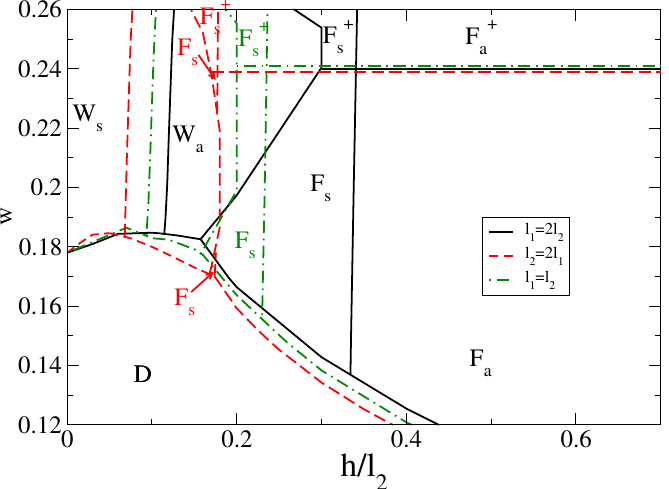
Figure 7. The same as Figure 4 for λ = 500. Colored labels F s and F + s identify the regions where these phases are stable for each l 1 / l 2 : black for l 1 / l 2 = 2, green for l 1 / l 2 = 1 and red for l 1 / l 2 =